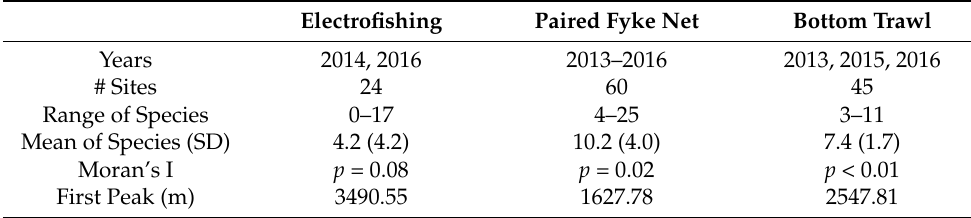
Table 1. Summary of Maumee Bay sampling results from 2013–2016.